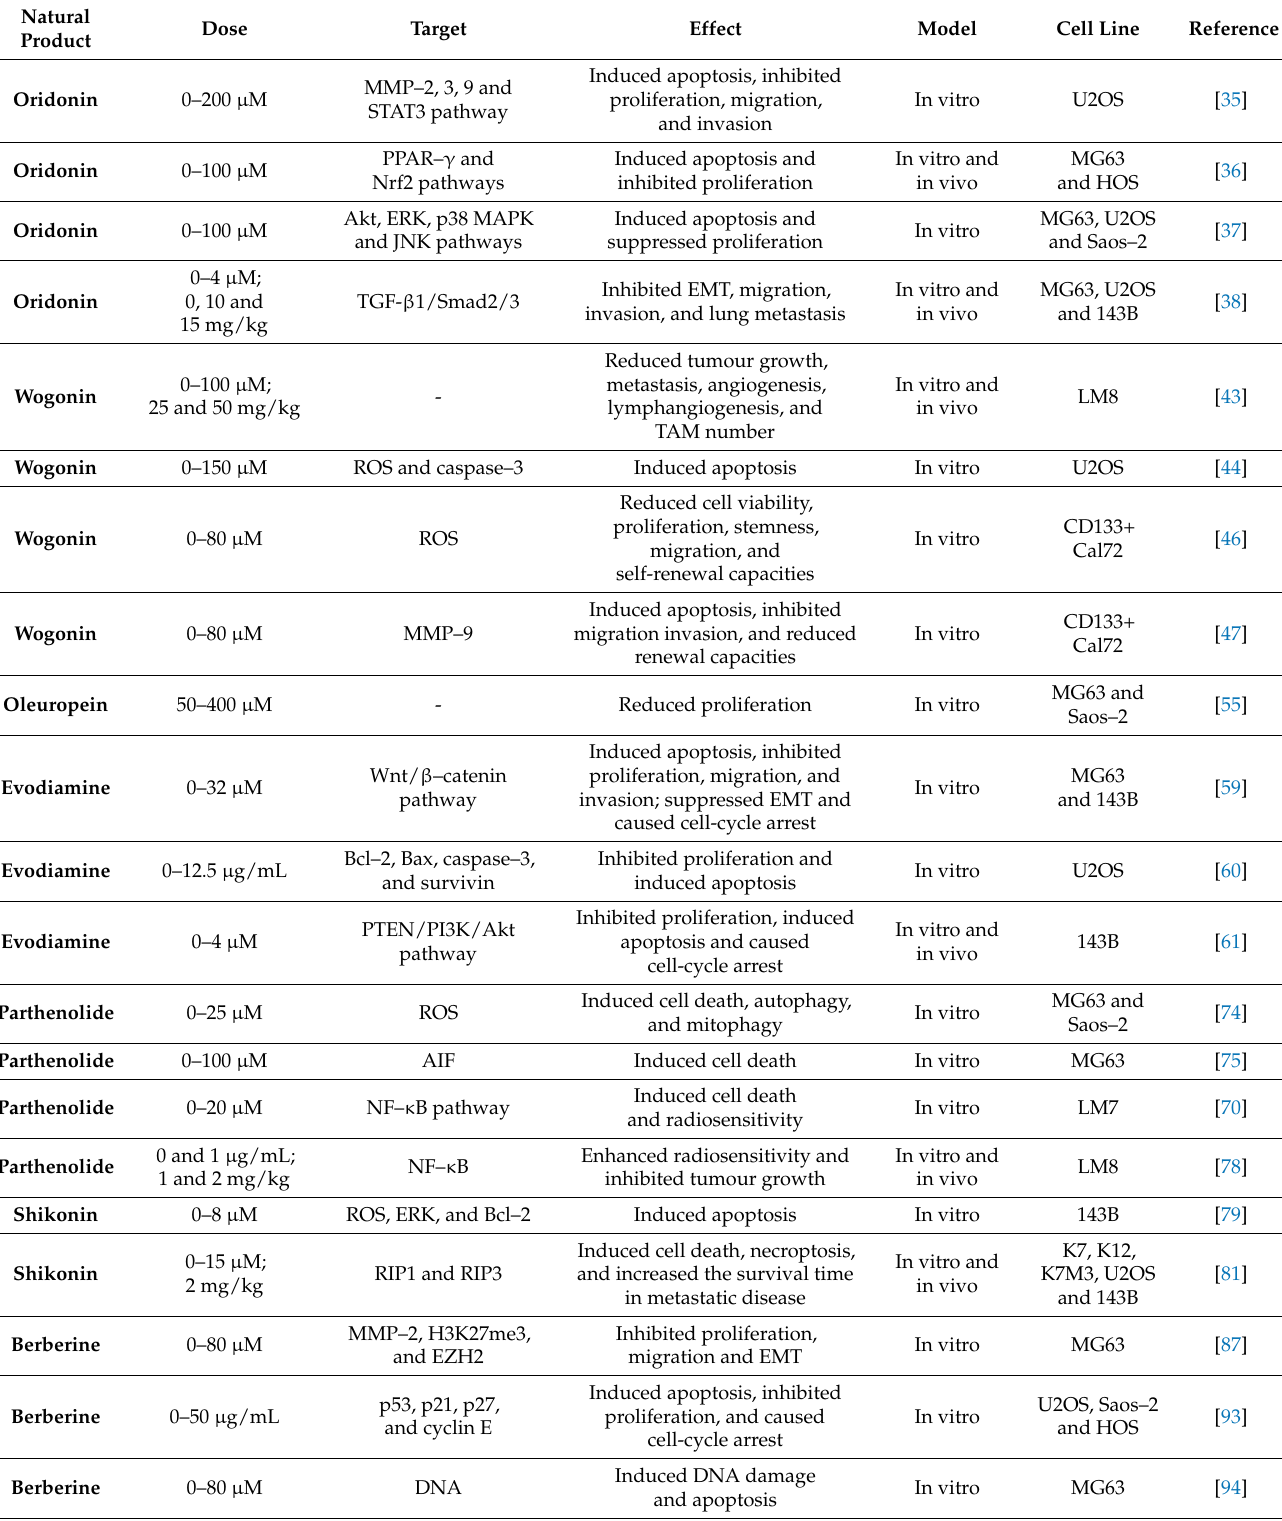
Table 2. The effects of different natural products on